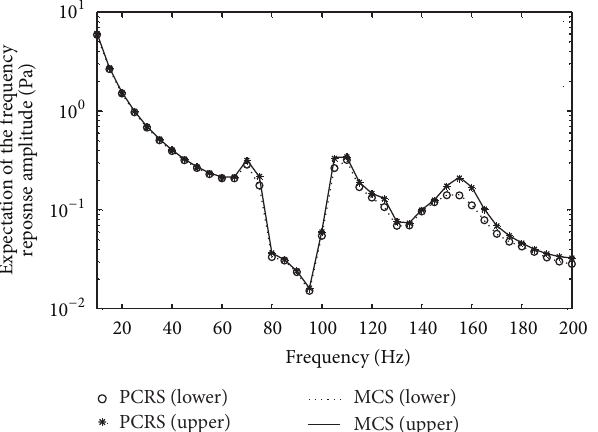
Figure 11: The lower and upper bounds of expectation of the frequency response amplitude at node 𝑅1 calculated by PCRS and MCS in the frequency band 𝑓 = 10 ∼ 200Hz.